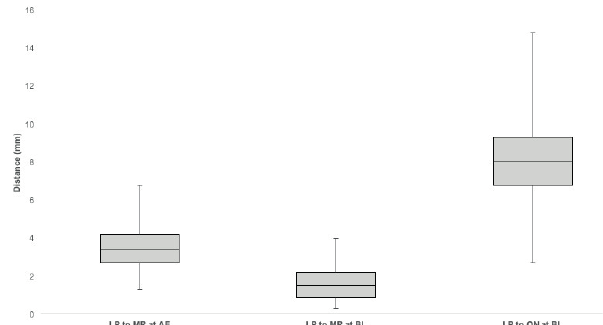
degrees.Figure 2. Distance from the lamina papyracea (LP) to medial rectus (MR) and optic nerve (ON) at depths of the anterior ethmoid (AE) and basal lamella (BL). Shown is a box-and-whisker plot for each measurement point. Total sides for each measurement point, N = 100. All measure- ments reported in millimeters